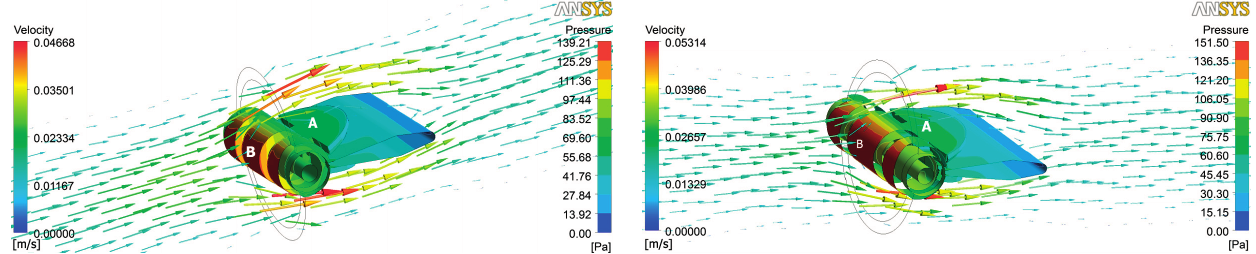
Figure 5. Velocity vectors and streamlines of the pressure on the wings of the valve. ( a ) the initial valve design; ( b ) the fabricated